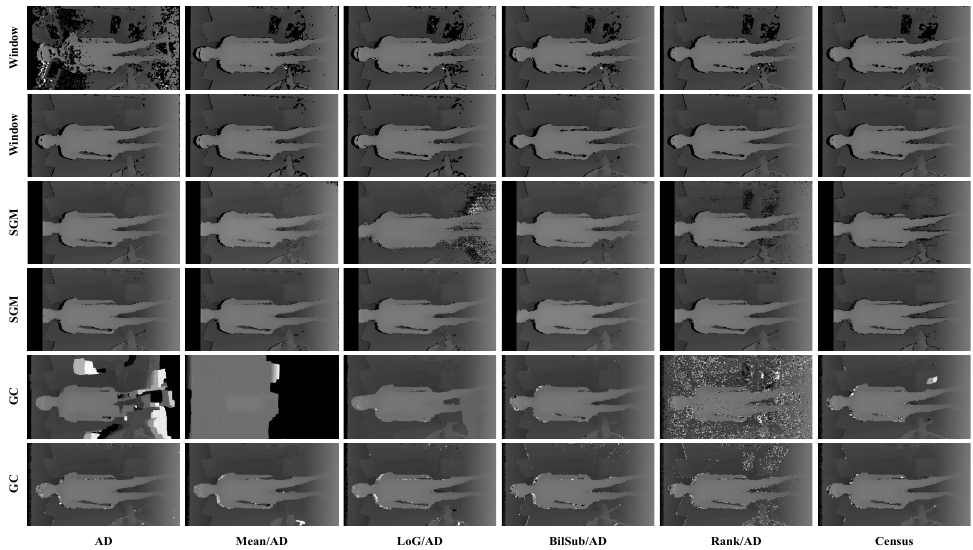
Figure 29. Estimated real disparity images of the combinations of cost and image filter using each stereo matching method, according to the pattern intensity parameter. The upper line indi- cates the low parameter, and the lower line indicates the high parameter for each stereo matching method,